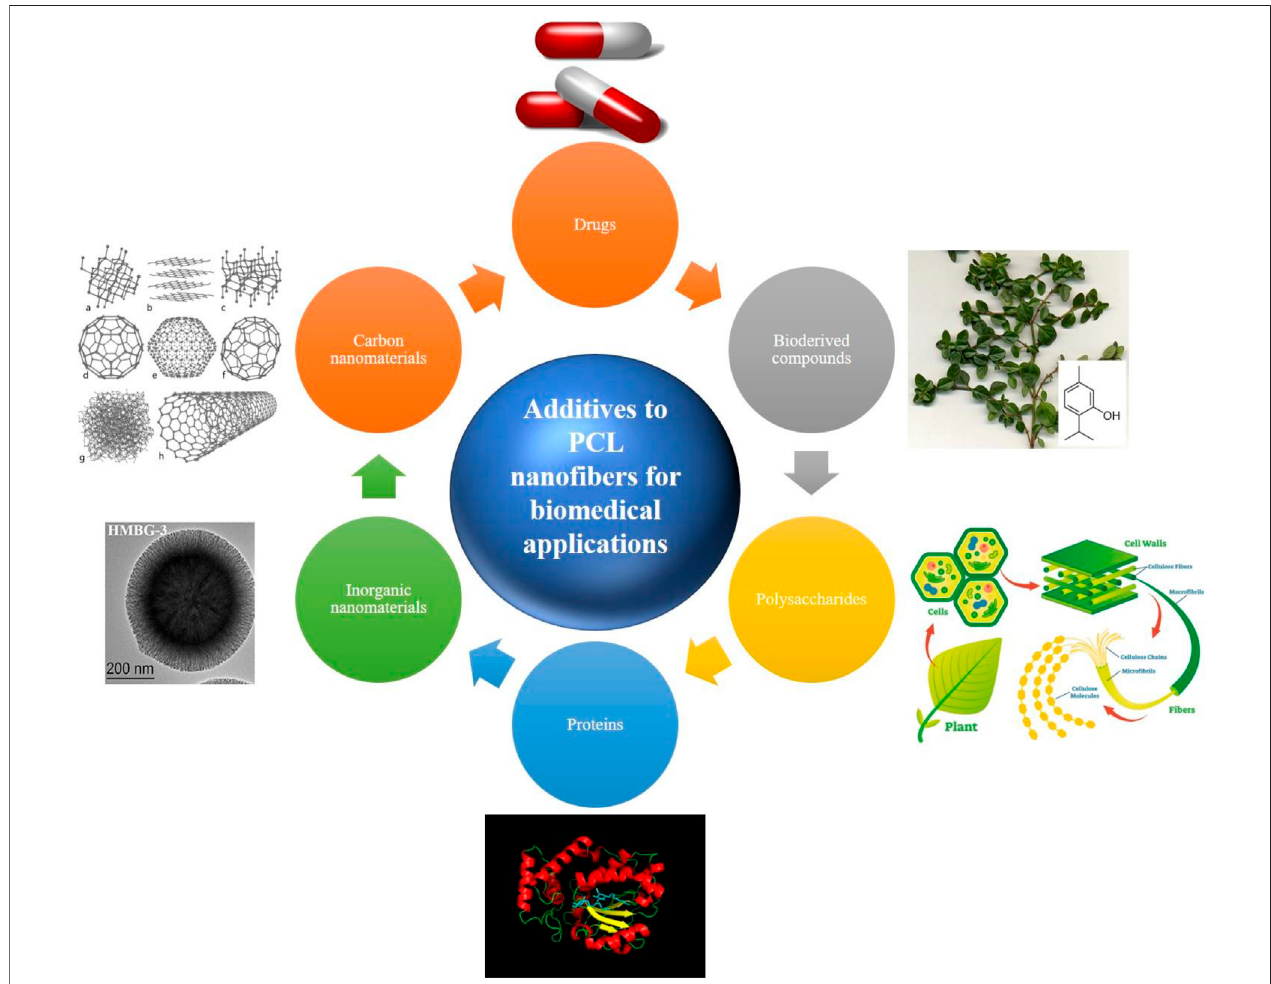
FIGURE 1 | Various classes of additives employed to reinforce biological and physicochemical properties of PCL nano fi bers. The used images have been reproducedwithpermission(inorganicnanomaterials(WangY.etal.,2019);CCBYlicence,proteins(upload.wikimedia.org/wikipedia/commons/9/95/Sec14p_Protein_ Figure.png; CC BY-SA 4.0), polysaccharides (researchoutreach.org/articles/cellulose-nanodefects-key-biofuels-biomaterials-future; CC BY-NC-ND 4.0), bioderived compounds (commons.wikimedia.org/wiki/File:Thyme-thymol; CC BY-SA 4.0), drugs (freepngimg.com/png/26873-pills-photos; CC BY-NC 4.0), and carbon nanomaterials (upload.wikimedia.org/wikipedia/commons/f/f8/Eight_Allotropes_of_Carbon.png; CC BY-SA 3.0).